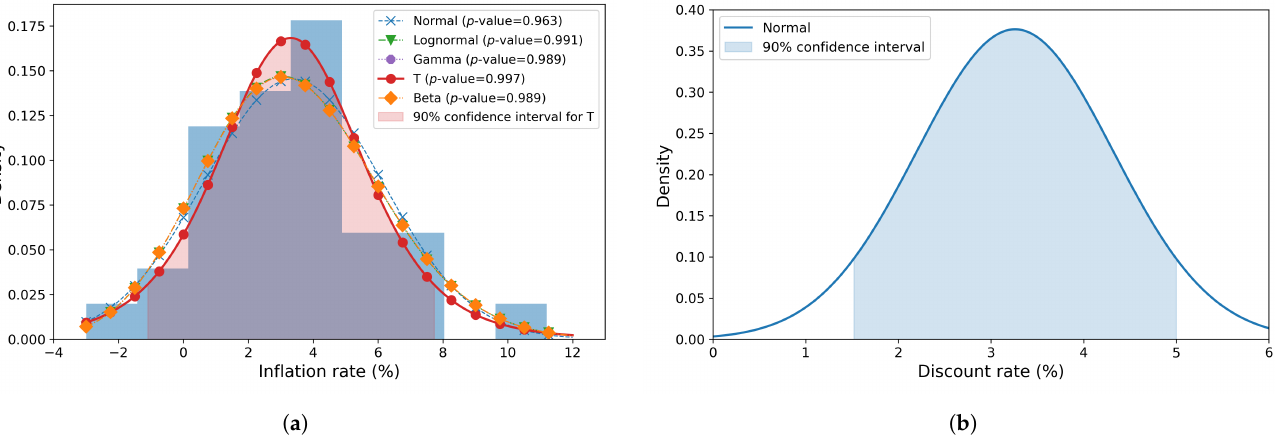
Figure 10. The curves of fitted probability distributions and their 90% confidence intervals: ( a ) his- togram against the five distributions of the inflation rate; ( b ) the normal distribution with a mean of 3.26 and a variance of 1.06 for the discount